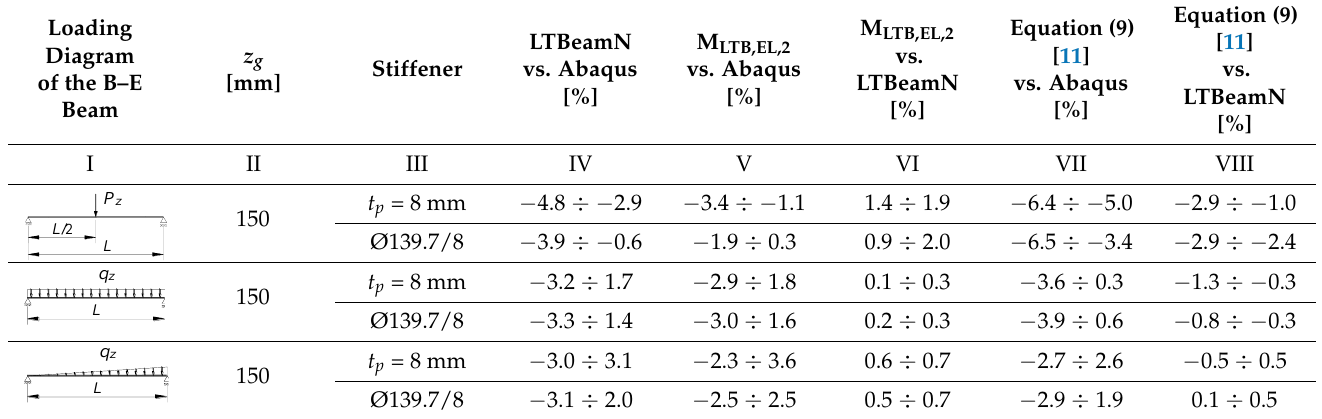
Table 8. Summary of the percentage differences of M cr for the B – E critical beam of the H-grillage. Loading Diagram of the B – E